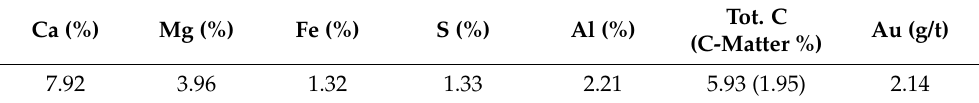
Figure 2. XRD analysis result of sample ore. Table 2. Element contents of sample ore.